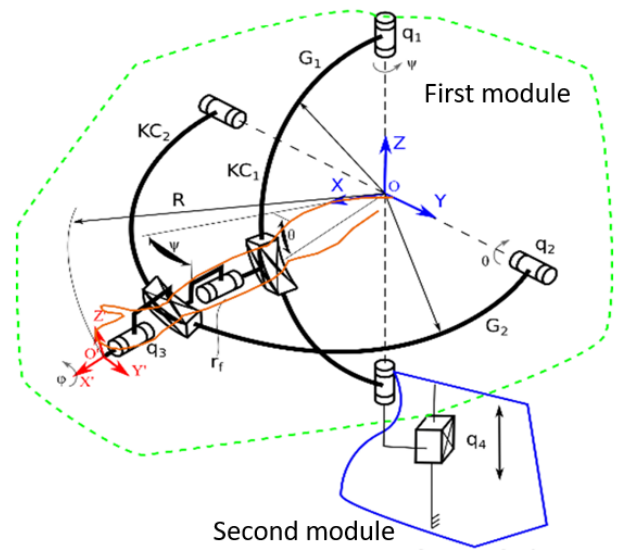
Figure 1. Kinematic scheme of ASPIRE [36].